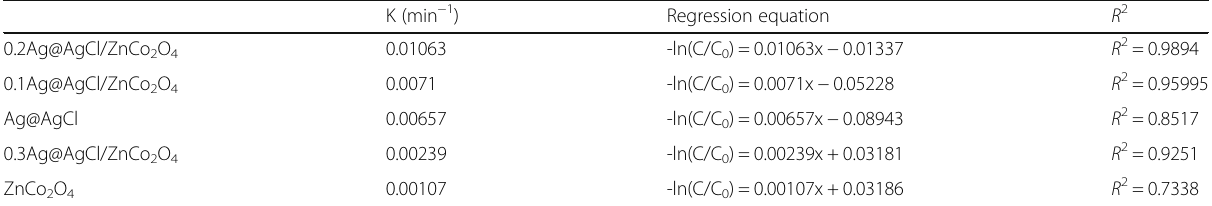
Table 1 Photodegradation rate constants and linear regression coefficients of different catalysts from equation – ln(C/C 0 ) = kt K (min − 1 )